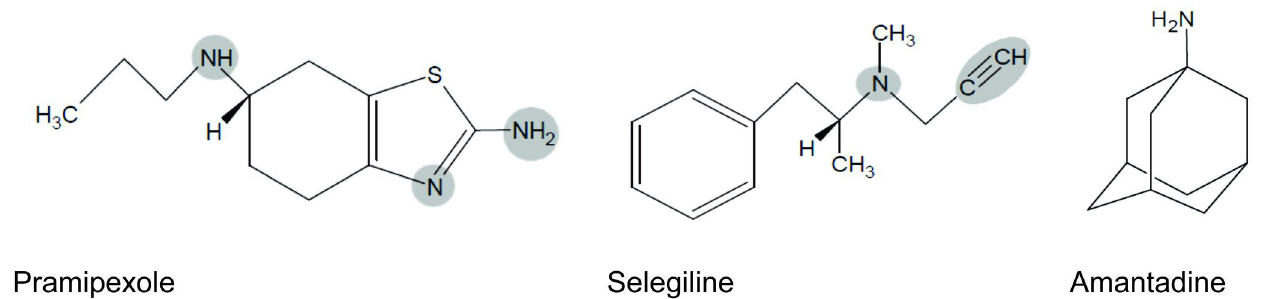
FIGURE 3 - Chemical structure of antiparkinsonian drugs. The structural characteristics of pramipexole, selegiline, but not amantadine, can define antioxidant action of these drugs. Highlighted areas would allow this antioxidant